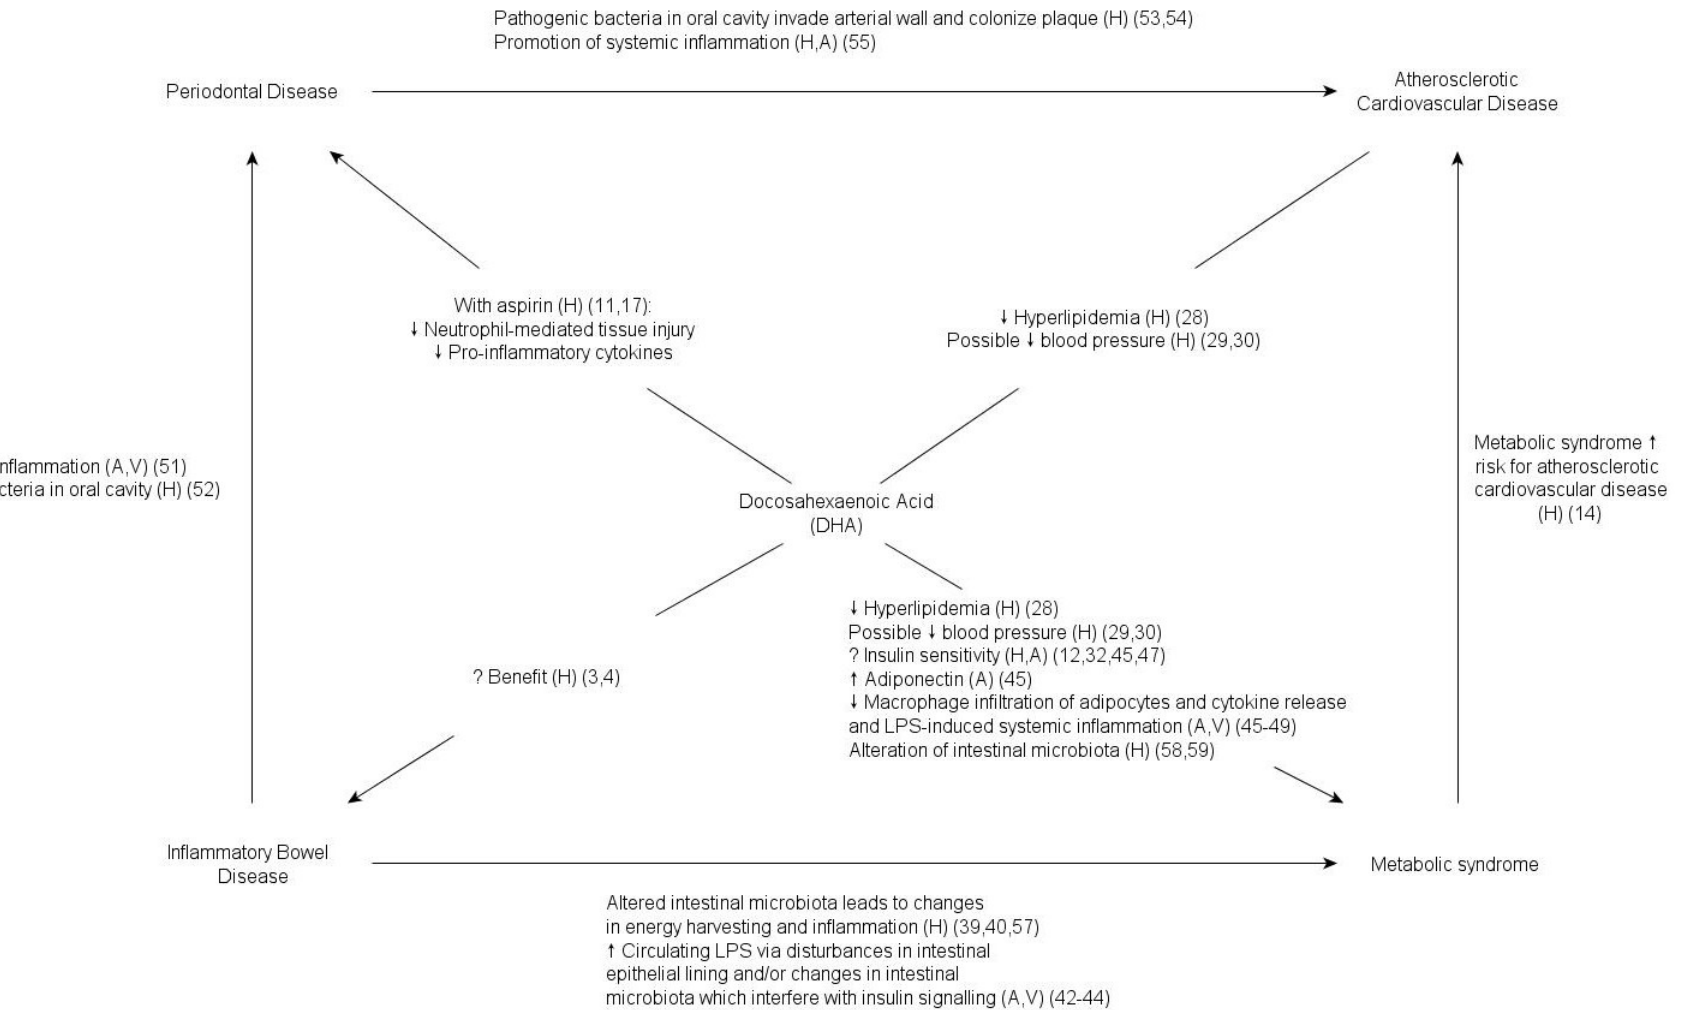
Figure 1. Established and proposed relationships between docosahexaenoic acid, periodontal disease, inflammatory bowel disease, metabolic syndrome, and atherosclerotic cardiovascular disease. A = Animal study; V = In vitro study; H = Human